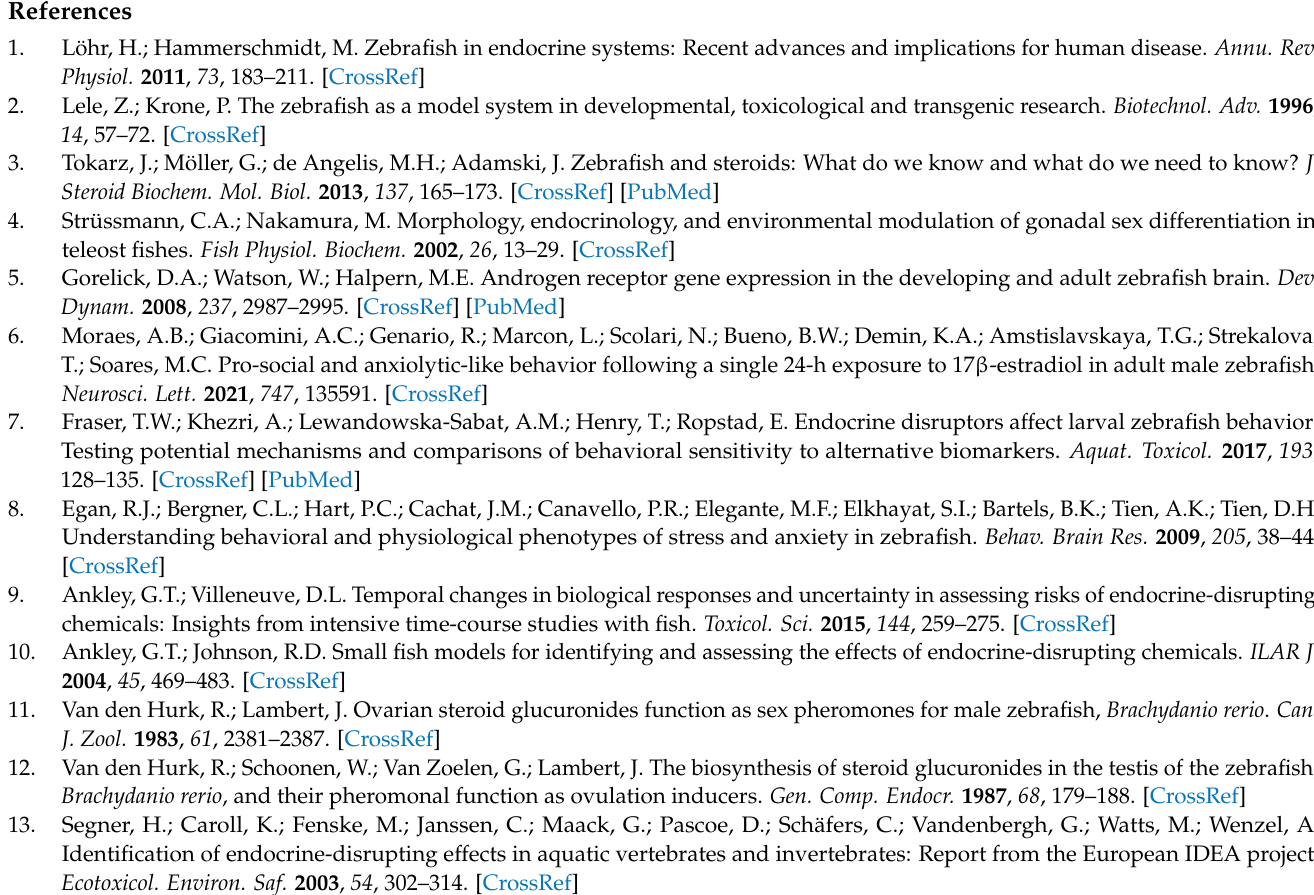
Table S1: Summary of LC–MS method for quantitative analysis of